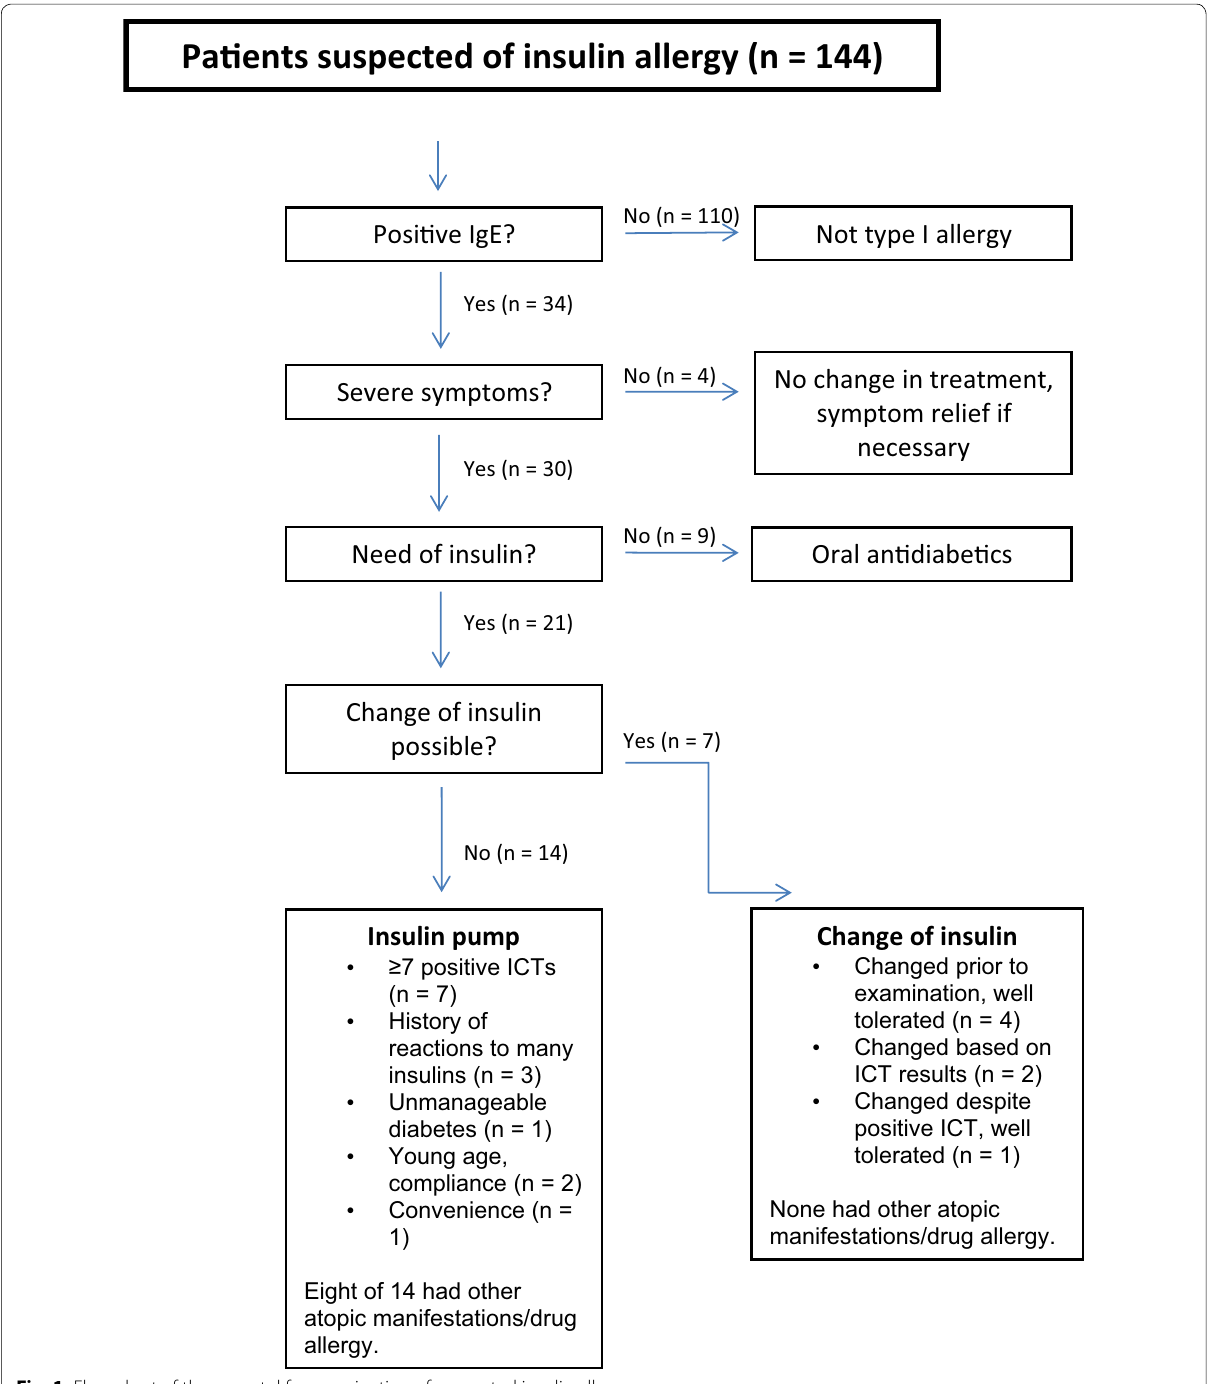
Fig. 1 Flow chart of the procotol for examination of suspected insulin